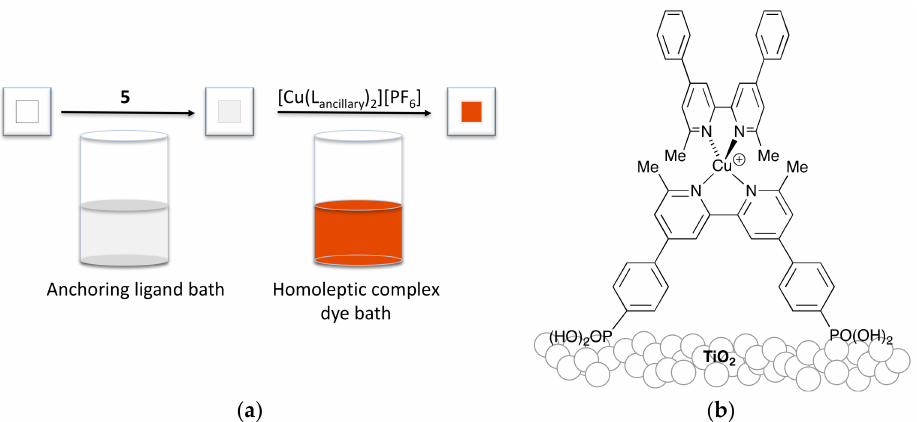
Figure 4. ( a ) The SALSAC approach to functionalization of a glass FTO/TiO 2 electrode surface with a heteroleptic [Cu(L anchor )(L ancillary )] + dye. Transparent electrodes were used for absorption spectroscopy, and TiO 2 with a scattering layer was used for DSSC measurements. ( b ) Surface-anchored [Cu( 5 )( 1 )] + .